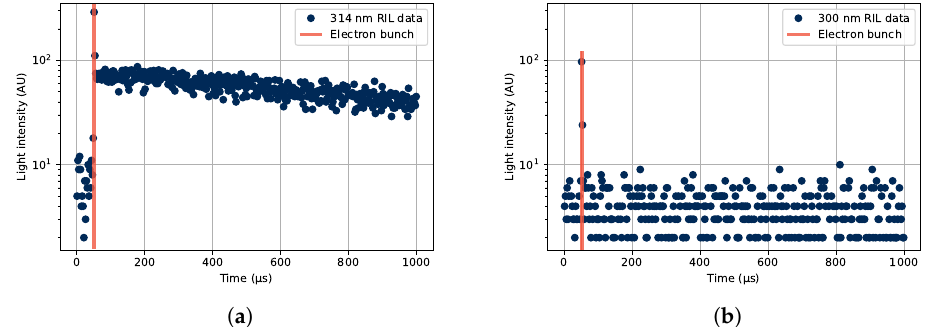
Figure 2. Examples of the time structure of the radiation-induced emission (RIE), as detected at different wavelengths under irradiation by a pulsed 20 MeV electron beam. ( a ) The radiation-induced luminescence (RIL) of the Gd 3 + -ions at 314 nm, along with the prompt radiation response during the electron bunch, marked with orange lines around 50 µ s into the collected digitized data